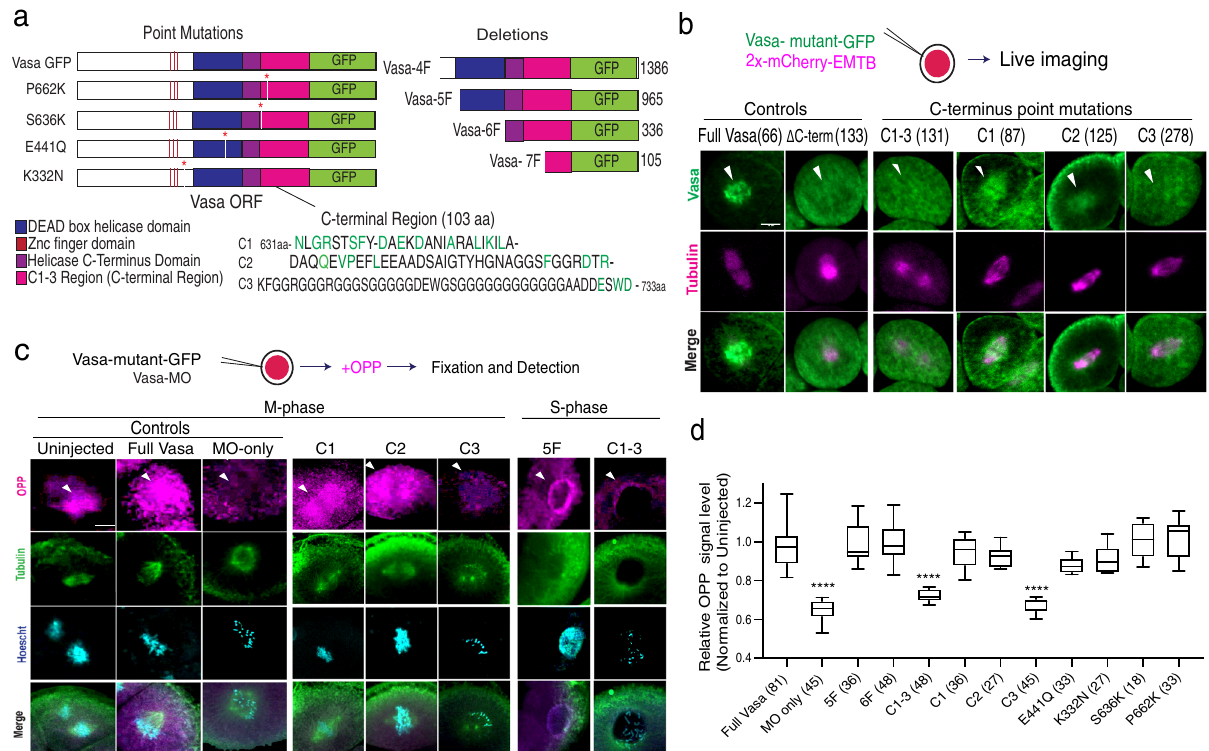
Fig. 5 Vasa C-terminus is responsible for localized translation on the spindle. a A schematic diagram of Vasa deletion or mutation constructs tested in this study. VasaC1-3 series are the constructs mutated for the Vasa-C-terminal regions (see also Supplementary Fig. S7 for detail). b Live imaging of the 8 – 16-cell embryonic cell injected with each of the Vasa mutants fused to GFP. Vasa ’ s spindle localization was lost in Vasa-C-terminal mutants (e.g., Vasa- Δ C-term, Vasa-C1-3, and Vasa-C3), yet not in other mutants except for Vasa-7F that lacks all of the conserved motifs important for DEAD-box helicase activities (Supplementary Fig. S7). c Localized translation on the spindle was measured by the OPP signal level in each embryo injected with each of the Vasa mutants along with Vasa morpholino antisense oligo to knock down endogenous Vasa activity. The OPP signal appears on the spindle when the introduced Vasa mutants are functional. A whole Z-section of the cell of interest (1 μ m per slice; ~35 slices in total) was imaged, analyzed, and presented as a maximum 2D-projection. The whole embryo images are presented in Supplementary Fig. S7. d Vasa C-terminus deletion or mutation resulted in the reduced signal of localized translation on the spindle. The relative OPP intensity level on the spindle versus in the cytoplasm was obtained as follows: The average signal level of three detection ROIs was obtained per embryo. A total of ~27 embryos were analyzed in this manner per sample group and the average value was presented in the graph. () indicates the total number of ROIs measured for each sample group. All experiments were performed at least three independent times. Adjusted p -value <0.0001. n = 81, 45, 36, 48, 48, 36, 27, 45, 33, 27, 18, 33 from the left-right columns of graph ( d ). The box plot de fi ned by two box lines indicates the 25th and 75th percentile, respectively, with a centerline at the 50th percentile and minima and maxima whiskers. Two-way ANOVA was used for all statistical analyses in this fi gure. **** p < 0.0001. Columns represent means± SD or SEM. All scale bars = 10 μ m. Source data are provided as a Source Data fi